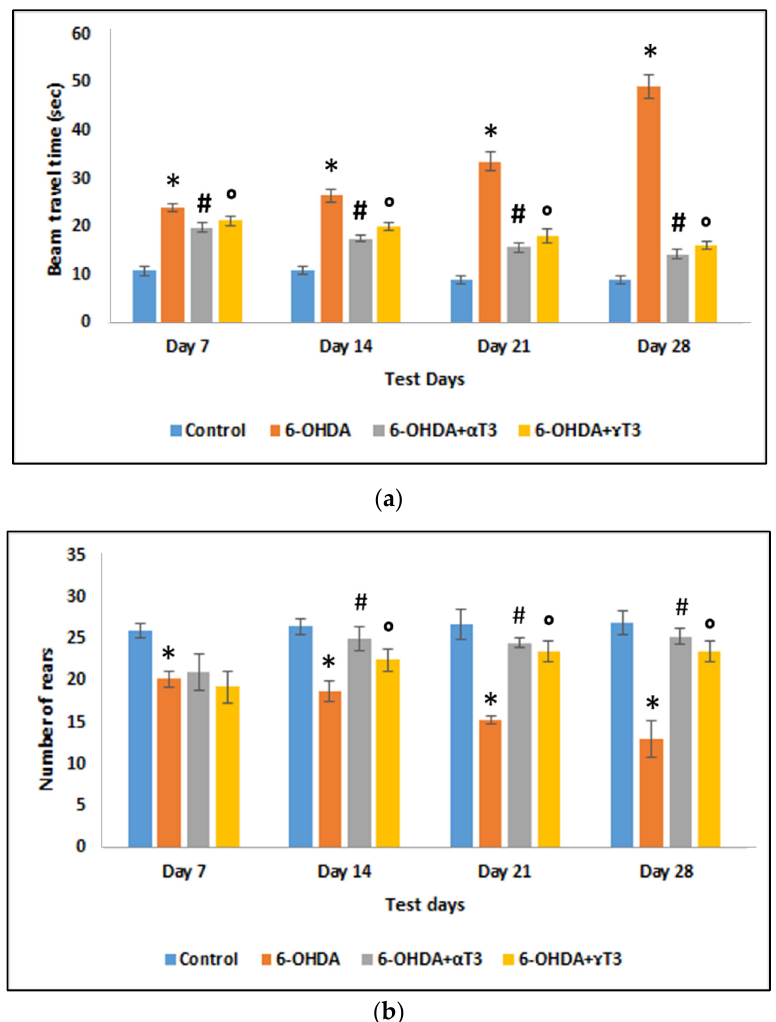
Figure 2. ( a ) Reduced beam travel time and ( b ) increased total number of rears in T3 ( α - and γ T3) supplemented groups compared to the 6-OHDA-injected group. ( n = 6; * p < 0.05 vs. control; # p < 0.05 vs. 250 µ g 6-OHDA; ◦ p < 0.05 vs. 250 µ g